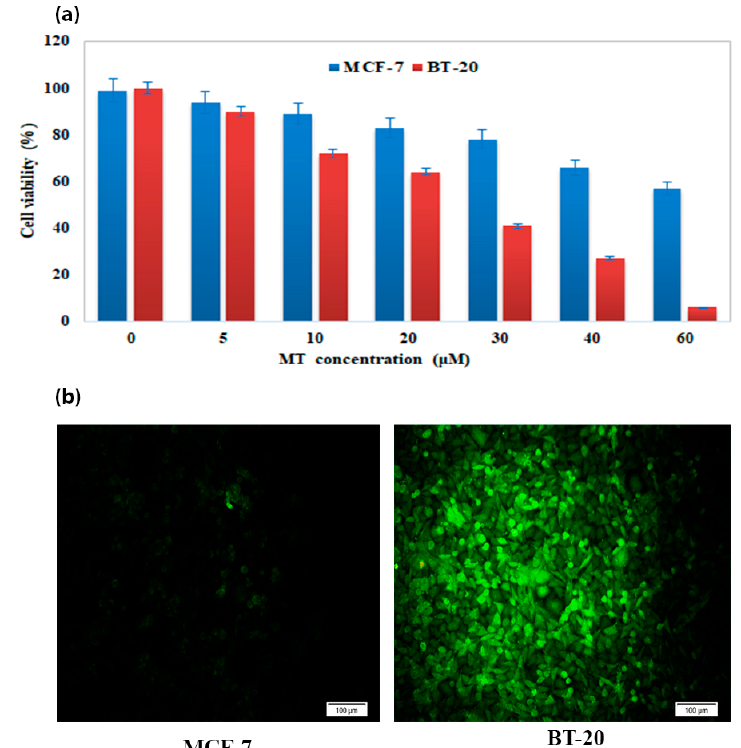
Figure 11. ( a )The effects of different MT concentrations (0.0–60 µM) on the cell viability on MCF-7 (negative CD44) and BT-20 (positive CD44) cells, ( b ) Immunocytochemical staining of CD44.Very high expression was observed in BT-20 a breast cancer cell line, while the CD44 expression was not detectable in MCF-7.